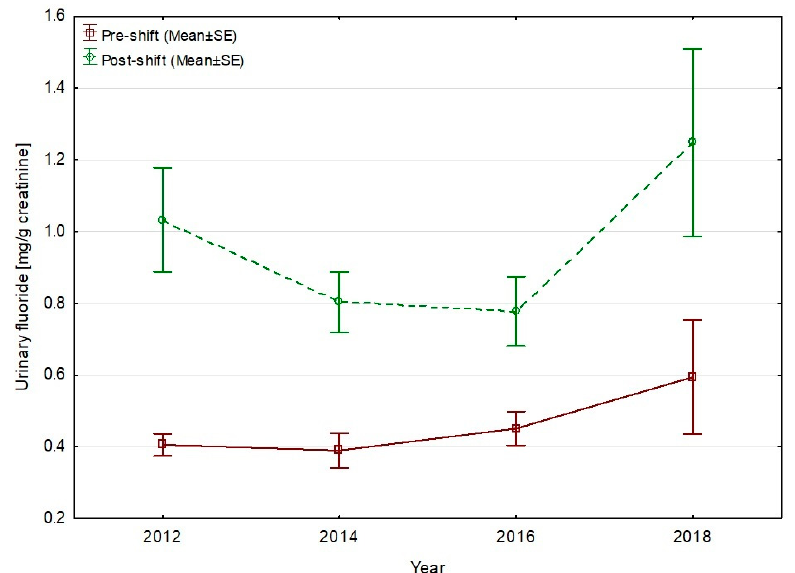
Figure 2. Comparison of urinary fluoride concentrations during the research period. Table 3. Relationship between fluoride concentrations in the occupational environment and post-shift urinary levels (Pearson correlation test result coefficient R, and p